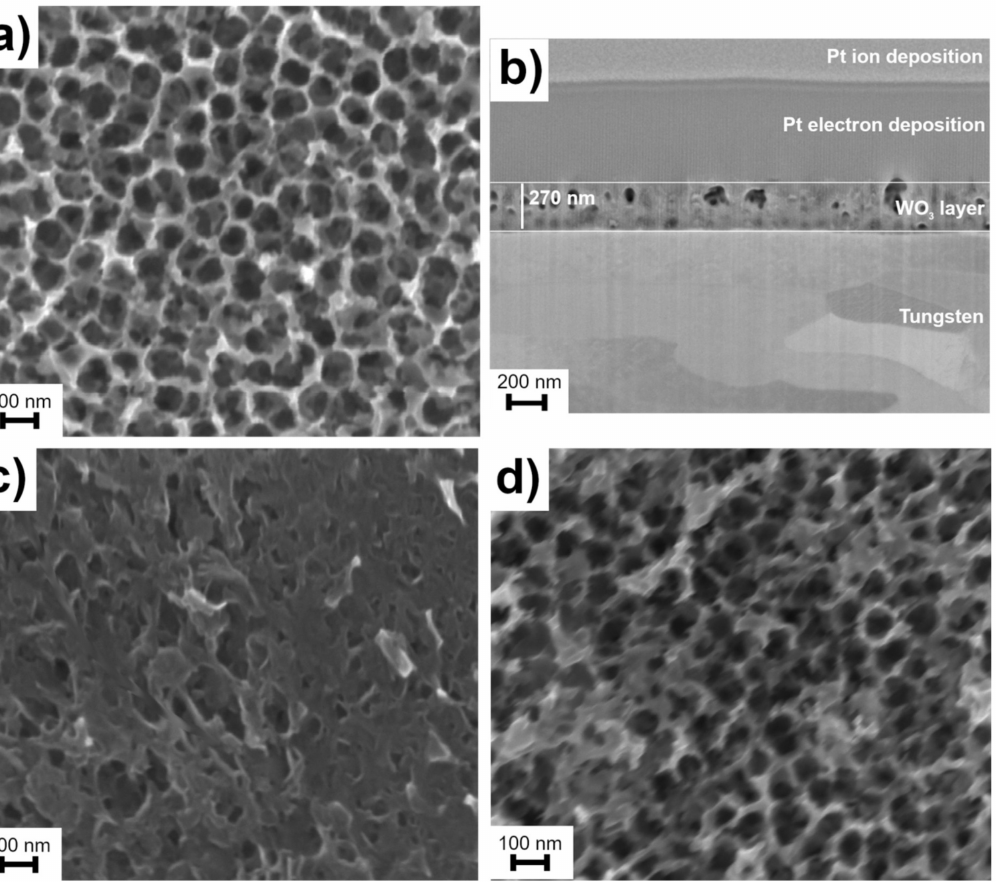
Figure 1. SEM micrographs of WO 3 surfaces obtained using various electrolyte composition: ( a ) 0.1 M NaF in 1 M H 2 SO 4 , without protective layer; ( b ) FIB cross-section of ( a ) after deposition of Pt protective layer; ( c ) 0.1 M (NH4) 2 SO 4 in water; and ( d ) 0.1 M NH 4 F in 1 M H 2 SO 4